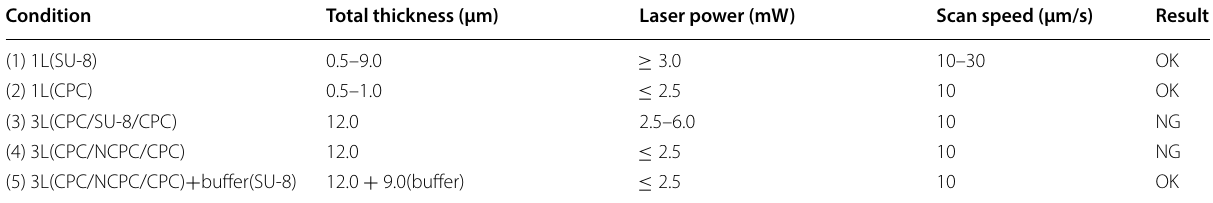
L: Layer, CPC: SU-8 and AgNPs of 7 vol % , NCPC: SU-8 and C 60 NPs of 2 vol %